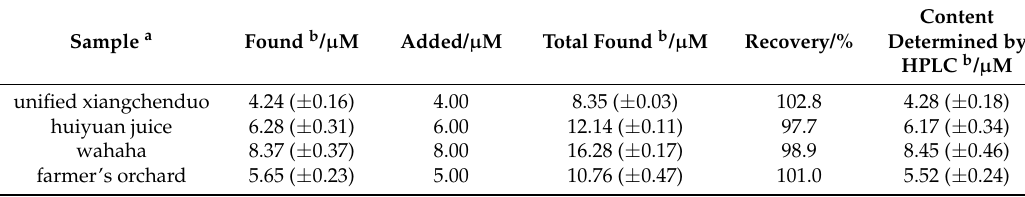
Table 3. Determination of SY in beverage samples ( n =